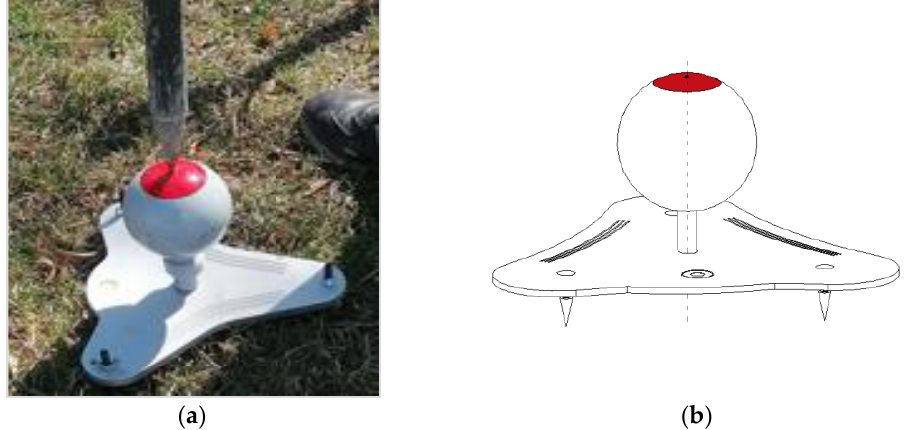
Figure 4. Author ’ s reference sphere for TLS and UAV measurements ( a ) Reference sphere during Figure 4. Author’s reference sphere for TLS and UAV measurements ( a ) Reference sphere during measurements ( b ) Construction of the proprietary reference sphere. measurements ( b ) Construction of the proprietary reference